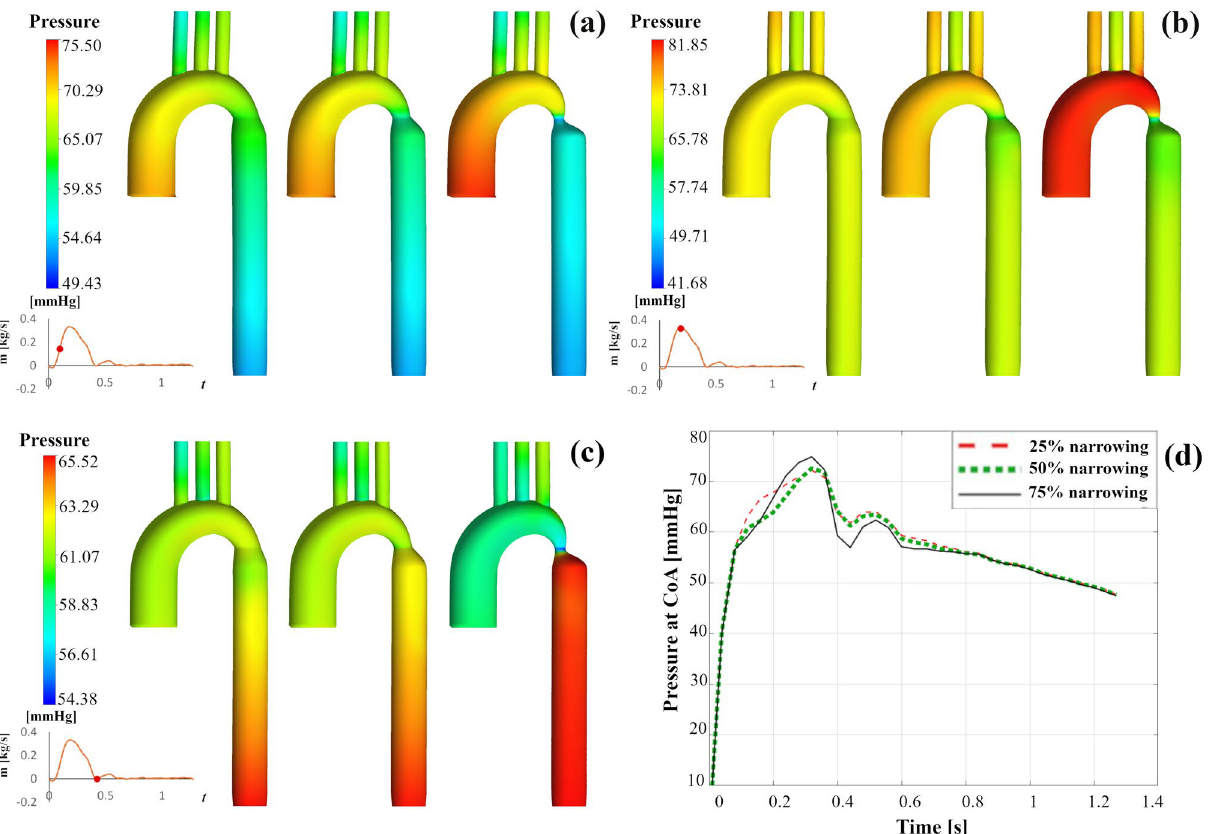
Figure 5. The distribution of pressure in the right anterior view at ( a ) mid systole, ( b ) peak systole, and ( c ) dicrotic notch (left: 25% coarctation, middle: 50% coarctation, right: 75% coarctation), ( d ) pressure distribution in CoA area in three cases against